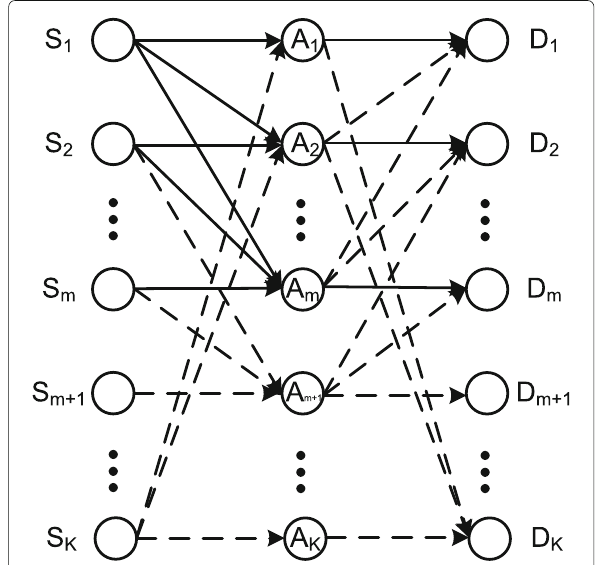
Fig. 15 Channel gain assignment in a two-layer ( K , m ) folded-chain network. All solidlinks have capacity n (for the linear deterministic model) and h (for the Gaussian model), and all dashedlinks have capacity 0